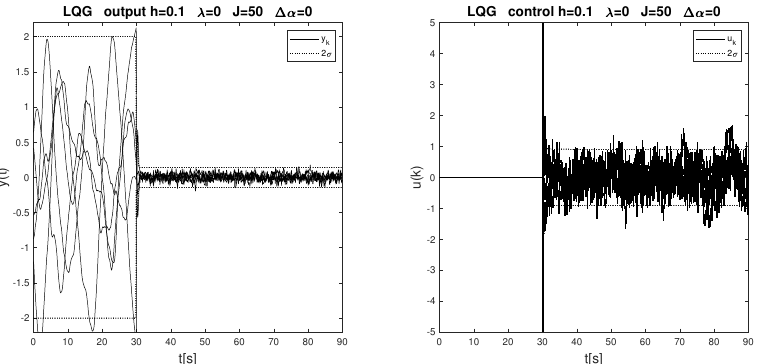
Figure 12. Realization of the output ( left ) and control ( right ) signal for λ = 0 and ∆ α = 0.